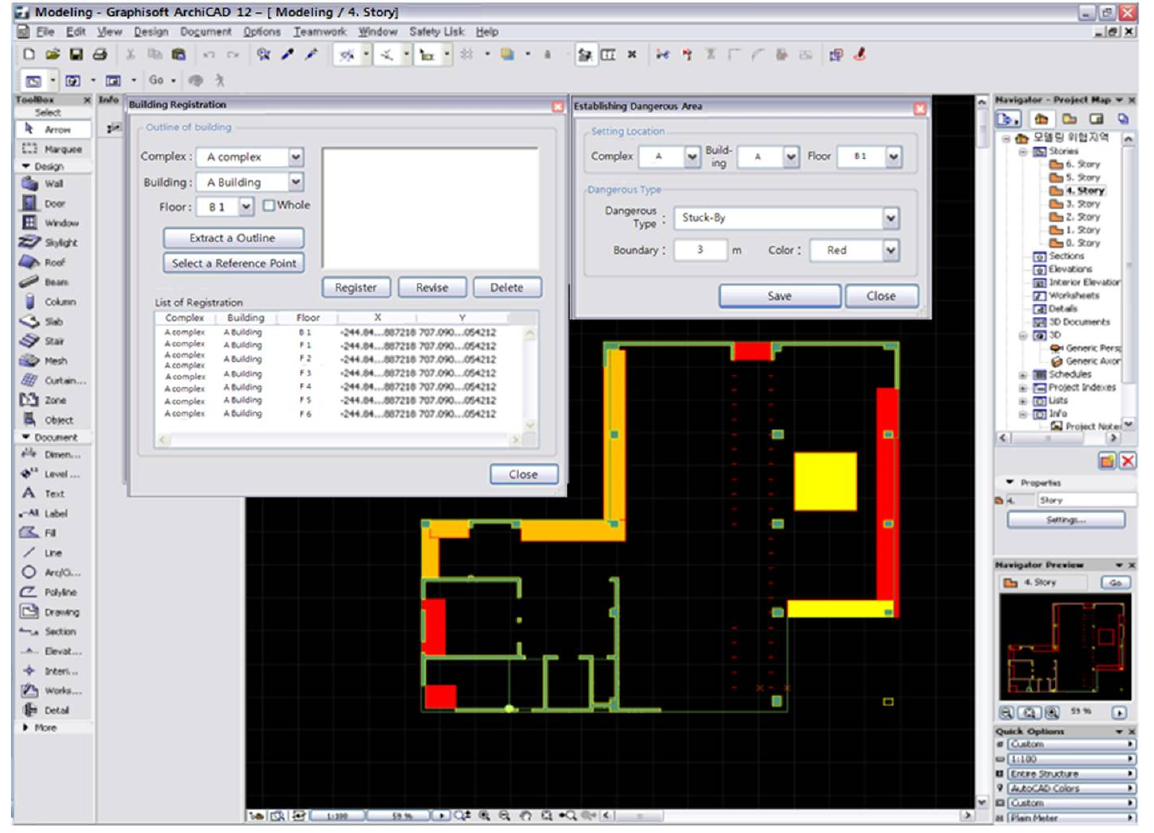
Fig. 3. Location monitoring system